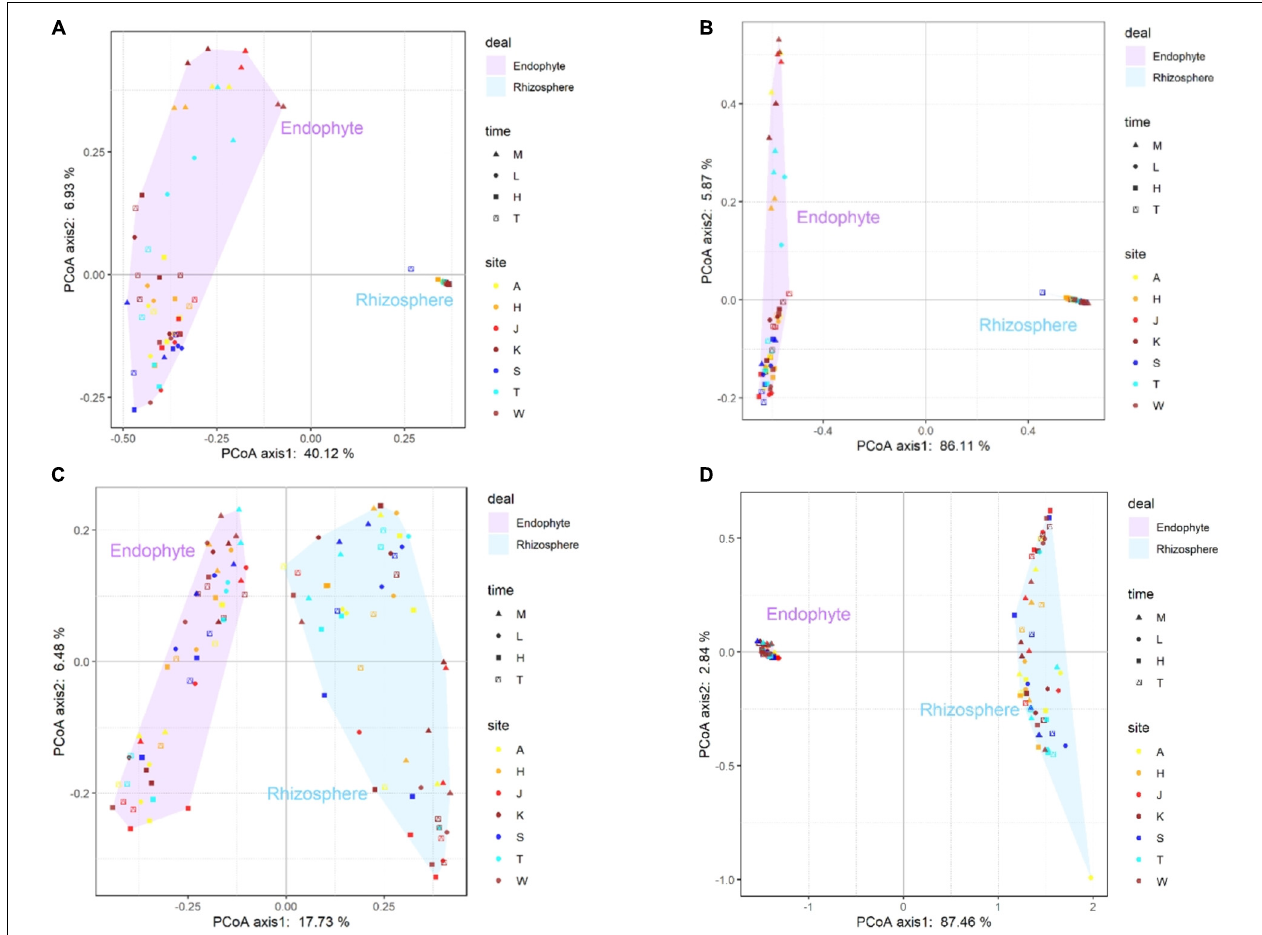
FIGURE 5 | The principal-coordinate analysis (PCoA) plots were based on Bray-Curtis (A) and weighted-unfrac (B) dissimilarity of bacterial (A,B) and fungal (C,D) communities in sampling site (A, K, T, H, S, W, and J represent the Alaer, Kuerle, Tumushuke, Hami, Shihezi, Wusu, and Jinghe, respectively) and growing season (M, L, H, and T represent seedling, bud, flowering, and boll opening stages, respectively) Differentiation in the rhizosphere and endosphere microbiomes was significantly (PERMANOVA p <